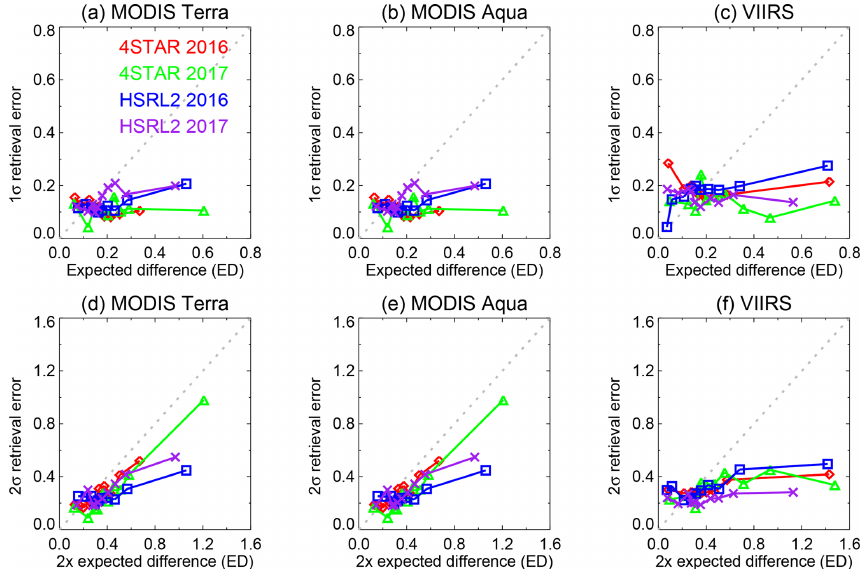
Figure 9. Comparison between magnitudes of expected difference (ED) and actual absolute retrieval errors. The top row shows ED (i.e. 1 σ uncertainty) against the 68th percentile (i.e. 1 σ ) retrieval error, binned as a function of ED. The bottom row shows 2 × ED (i.e. 2 σ uncertainty) against the 95th percentile (i.e. 2 σ ) retrieval error, for the same bins. Panels show (left–right) data for MODIS Terra, MODIS Aqua, and VIIRS matchups. Colours are as in Fig. 8. The 1 : 1 line is dotted